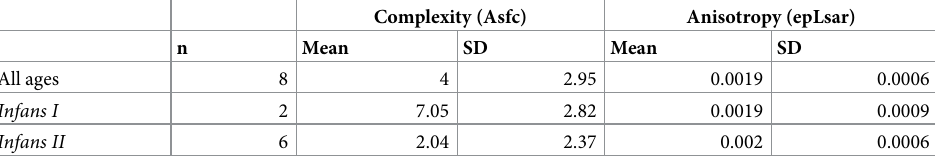
Table 4. Upper second deciduous and first permanent molar facet nine microwear texture.